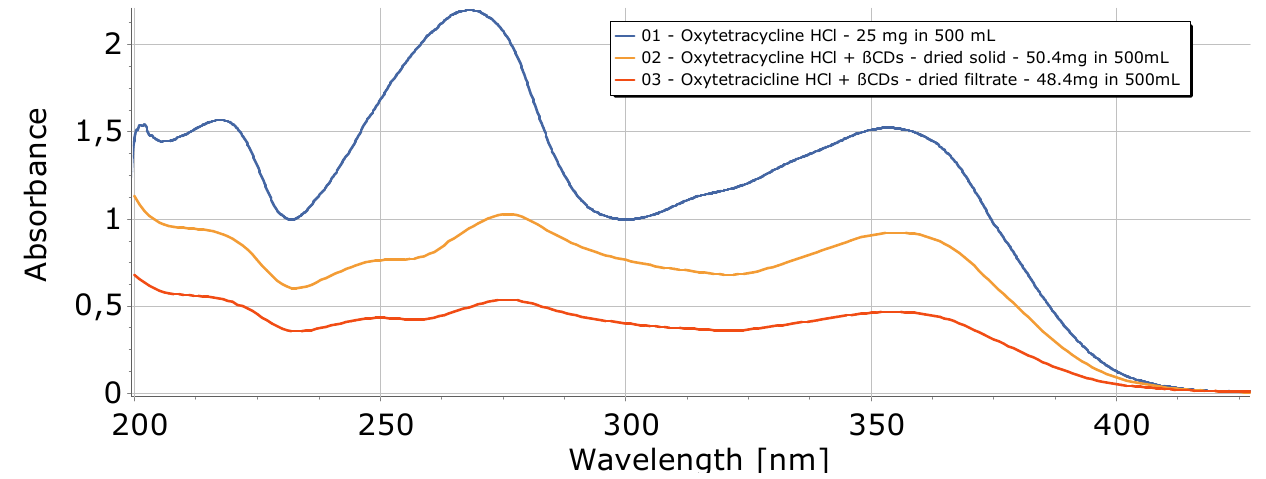
Figure 1. Oxytetracycline/ β -CD complex UV-Vis analyses. The so-formed complexes (150 mg) were hydrogenated in water (2 mL) under 5 bar of H 2 using an Rh/AC or Rh/Al 2 O 3 5 wt % commercial catalyst in a 1:1 weight ratio to the oxytetracycline: the catalyst amount is notably high but still halved compared to the starting work reported in the literature [13]. The reactions were performed under MW irradiation at 50 ◦ C for 2 and 4 h. The mixture was then filtered and washed with EtOH/water (1:1) to recover the products from the precipitated